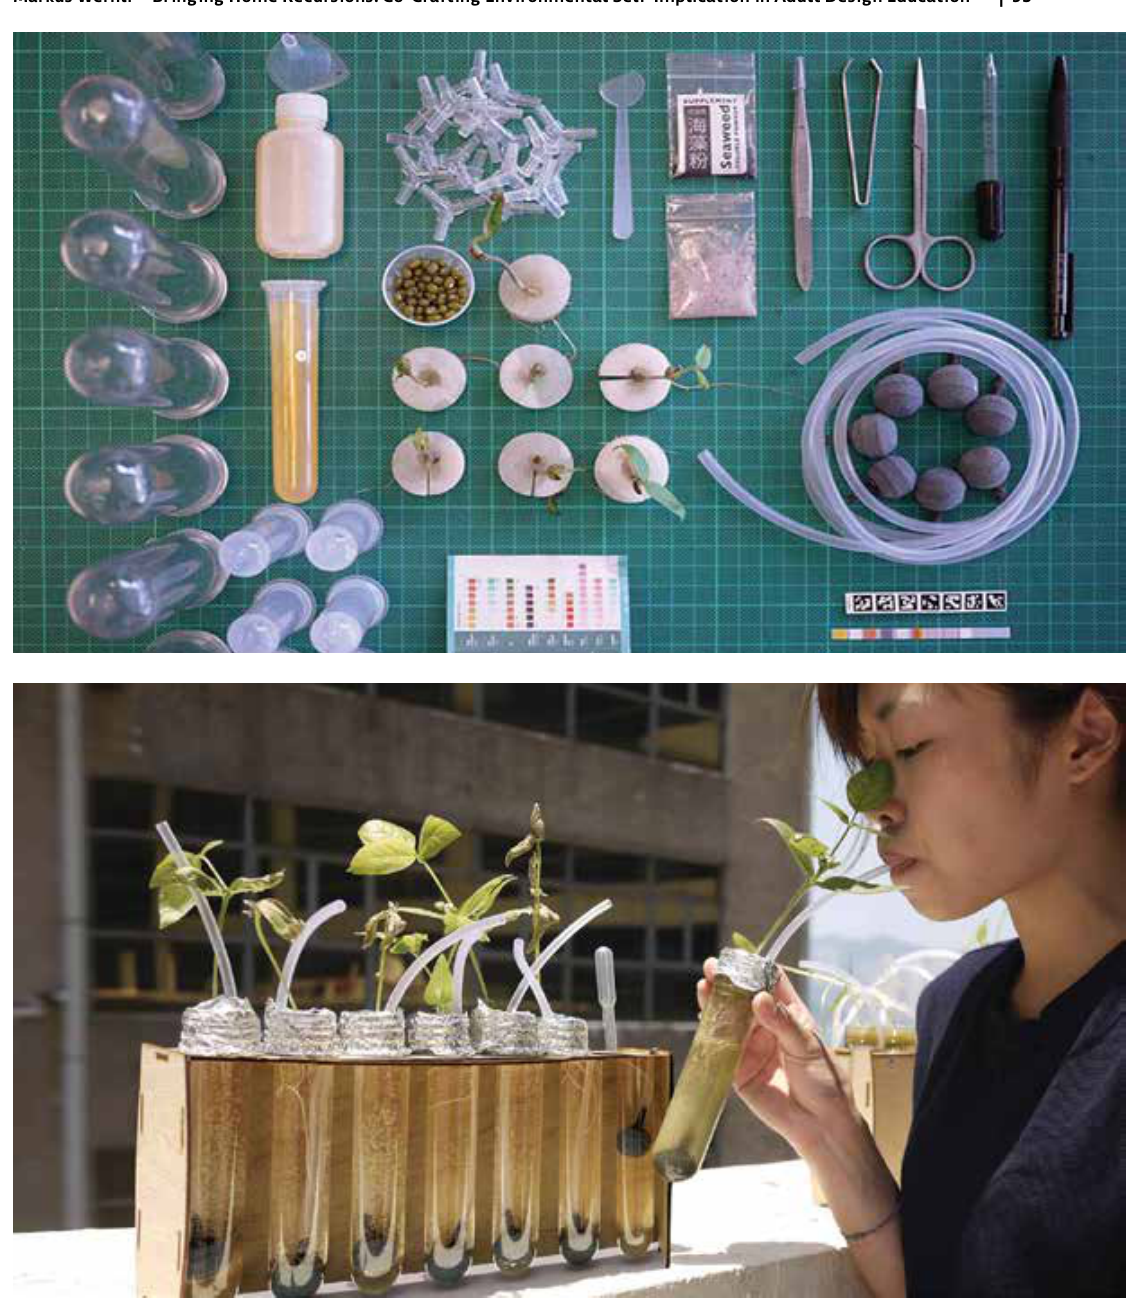
Figures 1 (top): Educational eco-health experiment around the integrity of the urine. The ANTHROPONIX curriculum repurposes urine into something that becomes desirable for reconnecting with our biological foundation. This co-crafting curriculum engaged 22 people who wanted to learn how their urine and personal eating choices can influence the prospering plants growing out of it. Photograph: Sarah Daher